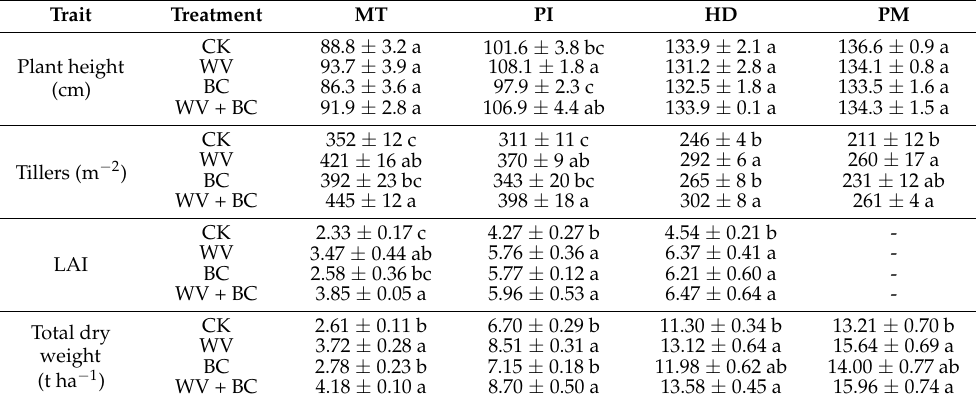
Table 6. Agronomic traits of different seed treatments of WDR at different growth stages under field experiment. Trait Treatment